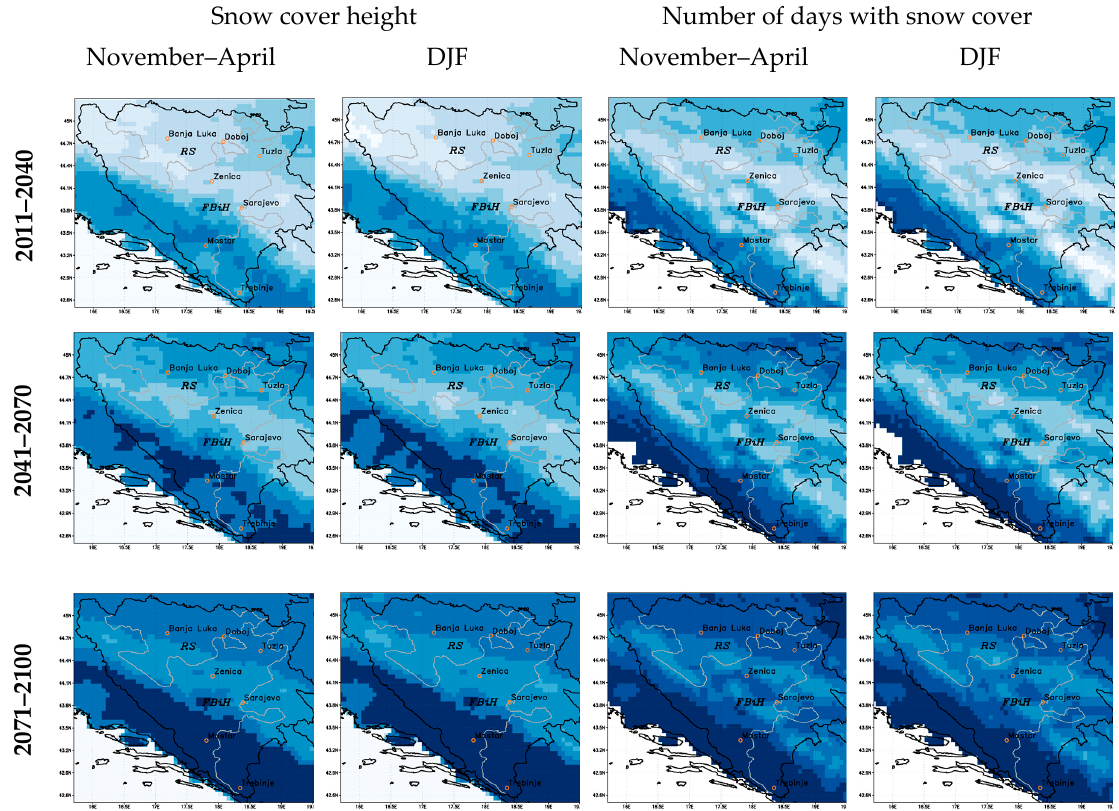
Figure 4. Change in the average snow cover height and number of days with snow cover for the November–April and DJF seasons, in %, for the periods 2011–2040, 2041–2070 and 2071–2100 compared to the period 1971–2000, according to the future climate scenario